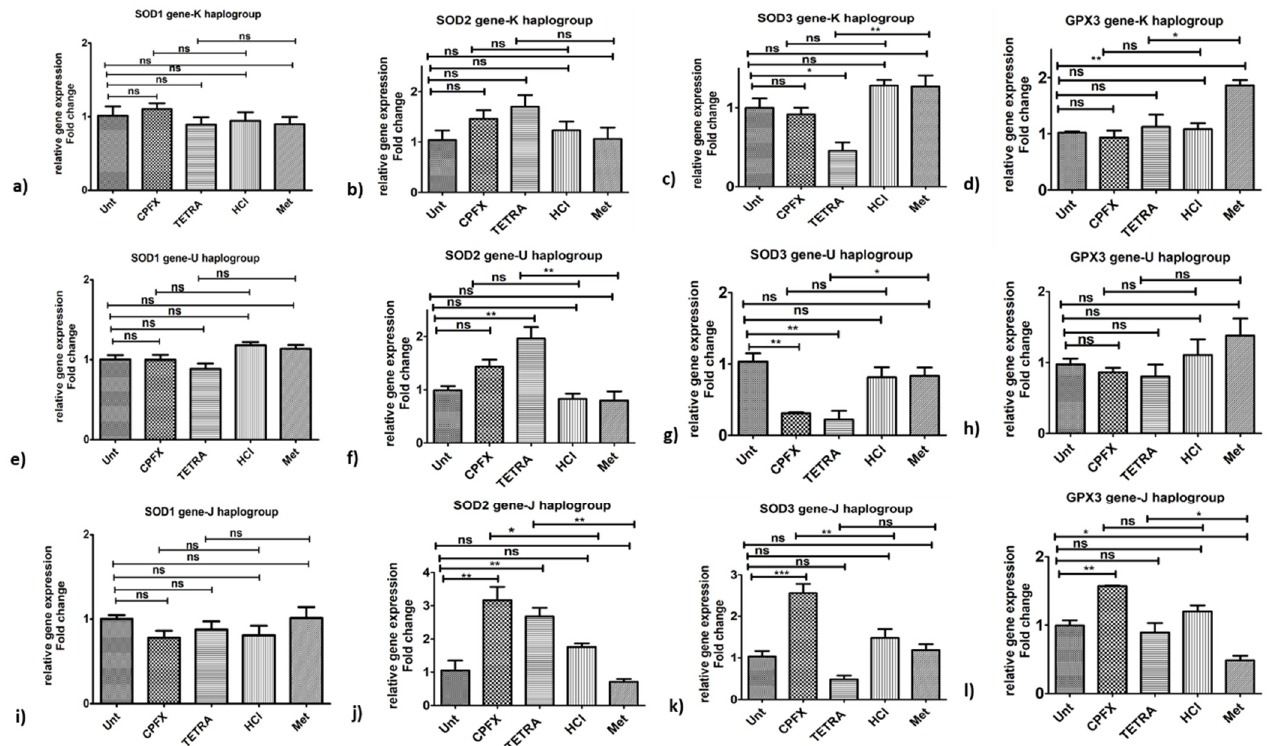
Figure 5. Impacts of CPFX and TETRA on genomic expression of antioxidant enzymes in K, U and J cybrids. In K cybrids, ( a , b ) no significant change in SOD1 and SOD2 by either treatment, ( c , d ) downregulation of SOD3 and GPX3 by TETRA. In U cybrids, ( e , h ) no significant change in SOD1 and GPX3 by either treatment, ( f ) higher expression of SOD2 and ( g ) lower expression of SOD3 via TETRA. In J cybrids, ( i ) no significant change in SOD1 by either treatment, ( j ) upregulation of SOD2 via CPFX and TETRA, ( k ) higher expression of SOD3 by CPFX, and ( l ) overexpression of GPX3 by CPFX. (* p < 0.05, ** p < 0.01, *** p < 0.0001).